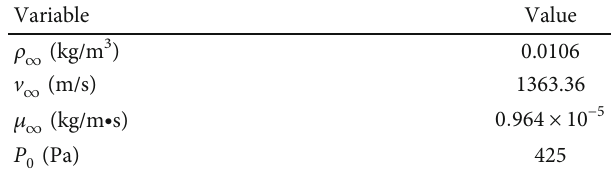
Table 2: In fl ow conditions of the experiment.